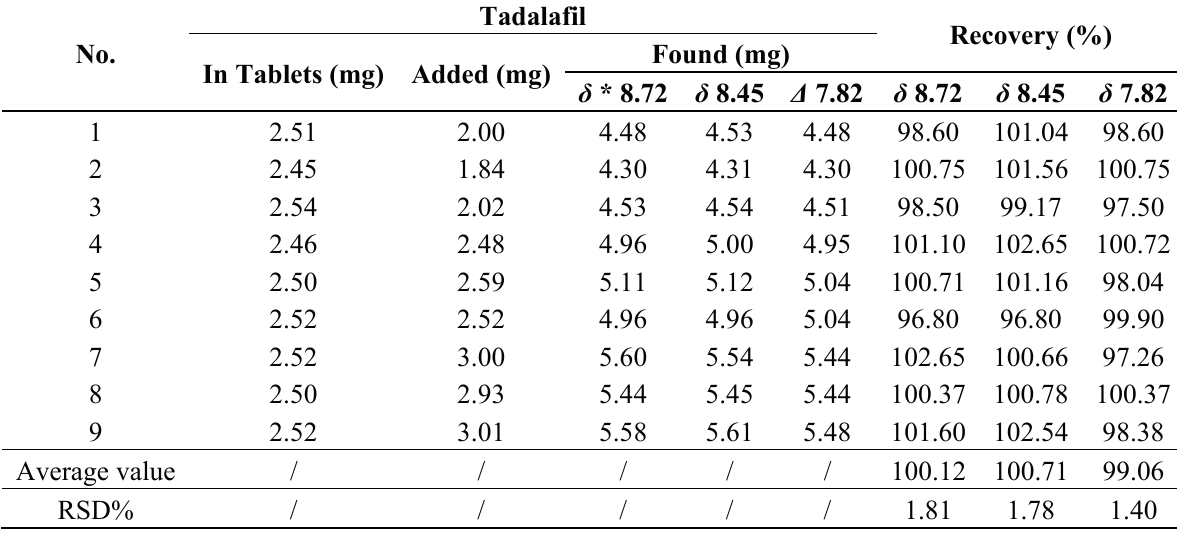
Table 3. Recovery of tadalafil from tablets.